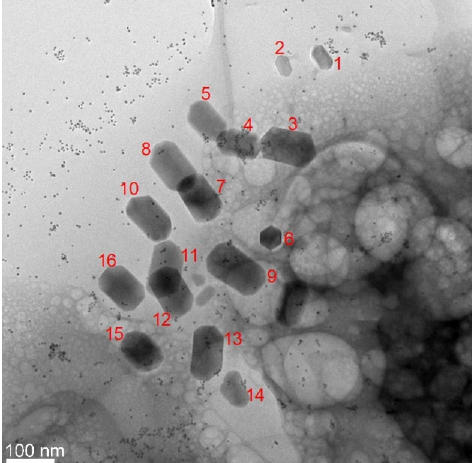
Figure 5. Low-magnification TEM image of a typical assembly of magnetosomes mineralized inside a magnetotactic bacterium.